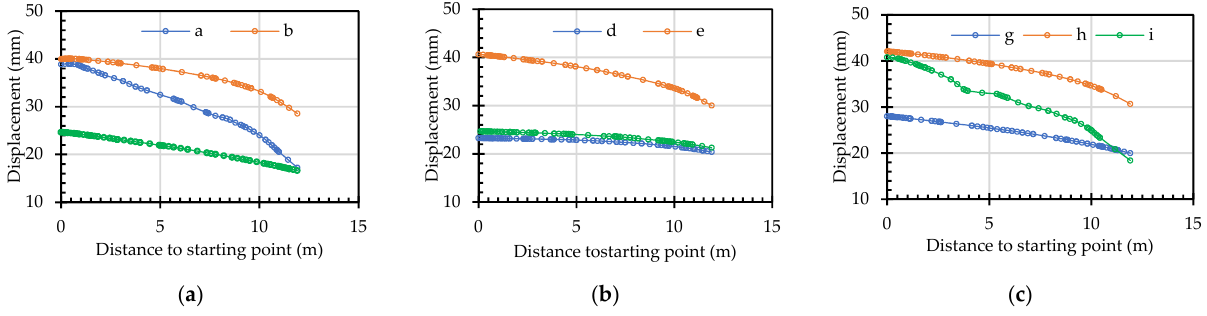
Figure 20. Displacement vs. location under unbiased pressure: ( a ) for pipe roofings a, b, and c in the westbound tunnel; ( b ) for pipe roofings d, e, and f in the MRT tunnel; and ( c ) for pipe roofings g, h, and i in the eastbound tunnel.